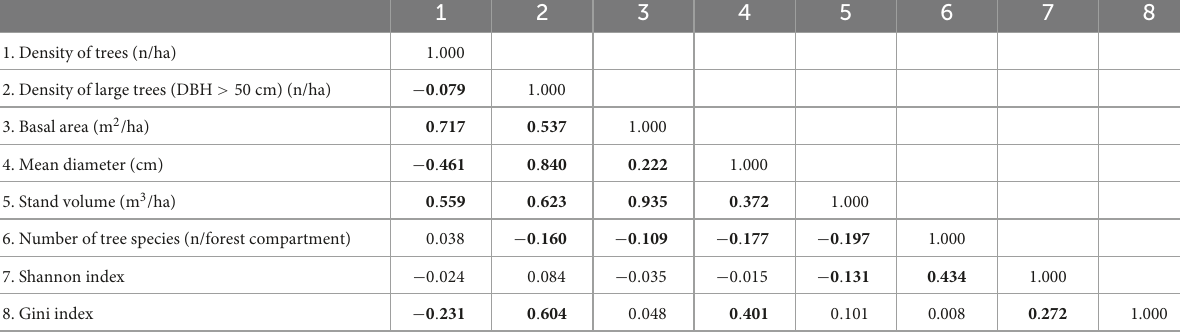
TABLE 1 Correlation matrix between structural indicators (Spearman correlation